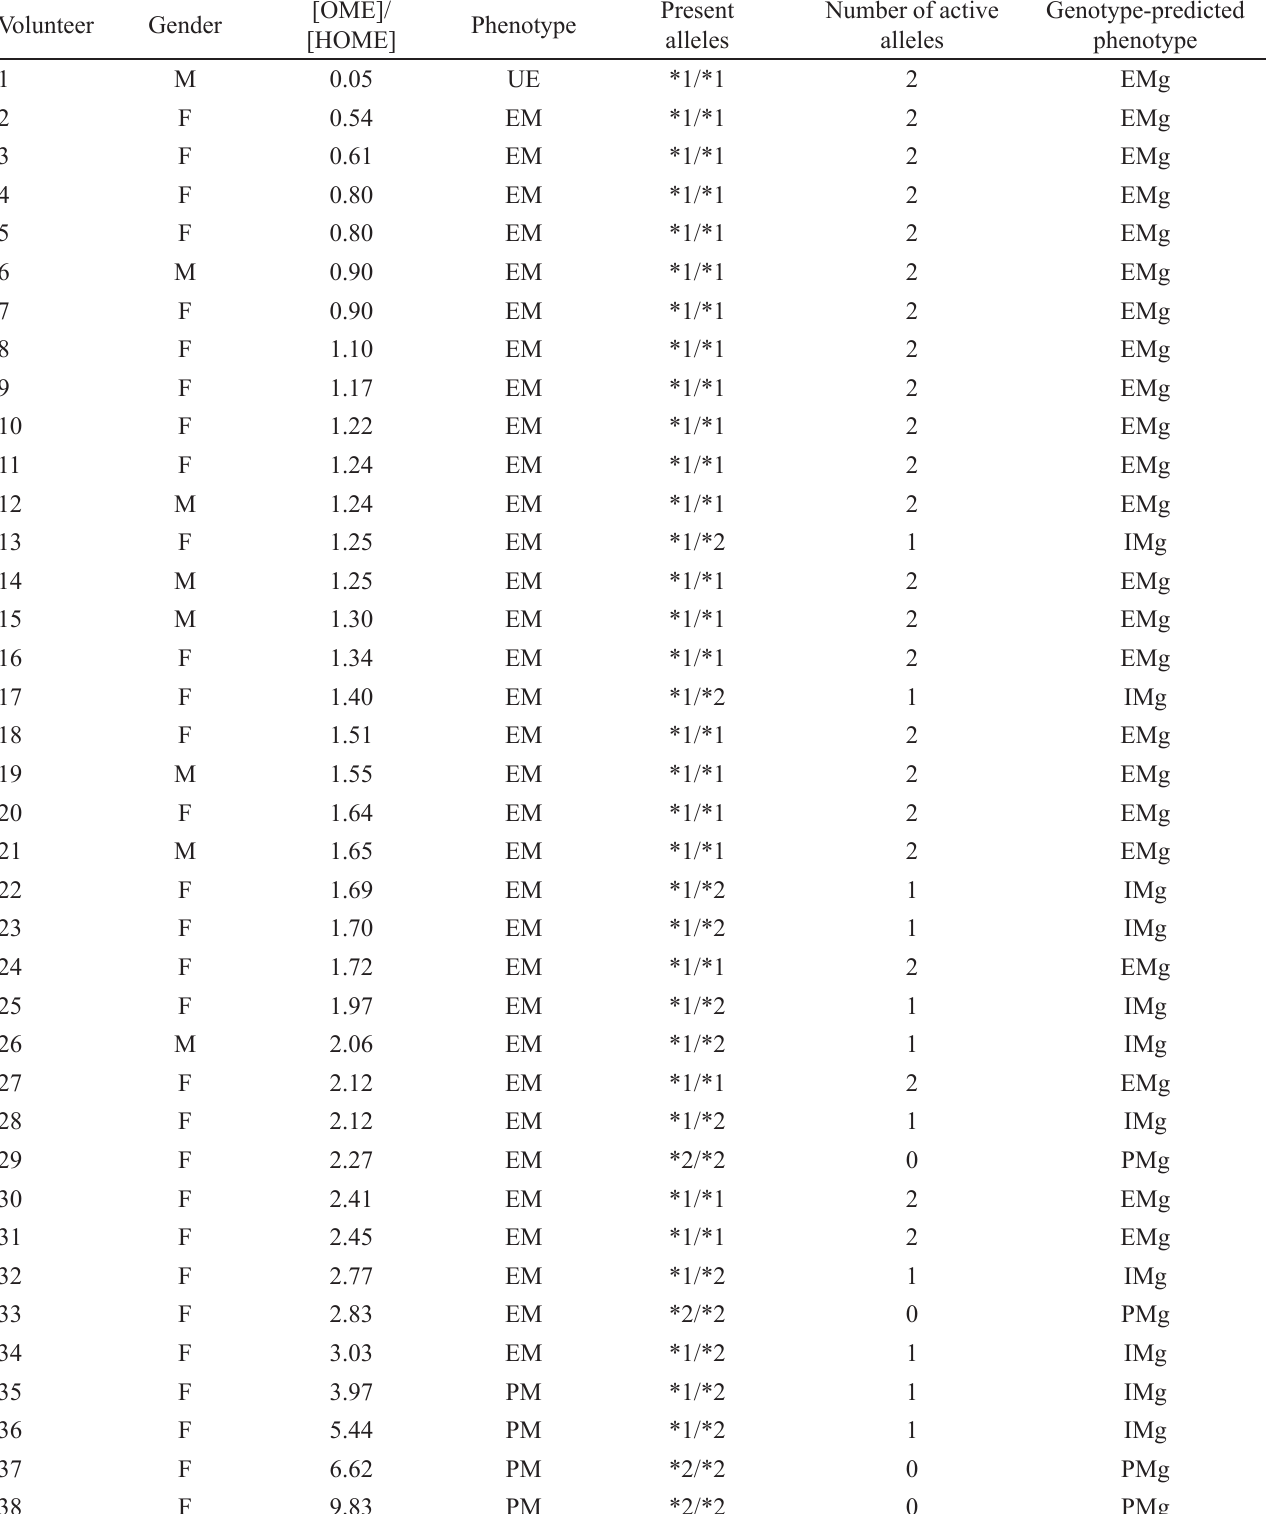
TABLE I - CYP2C19 phenotyping and genotyping data of volunteers Volunteer Gender